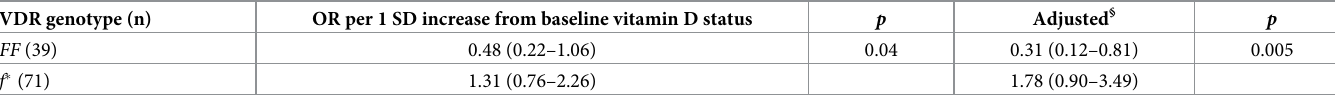
Table 3. Logistic regression for late stress fracture risk–including vitamin D receptor (VDR) x vitamin D status increase interaction. VDR genotype